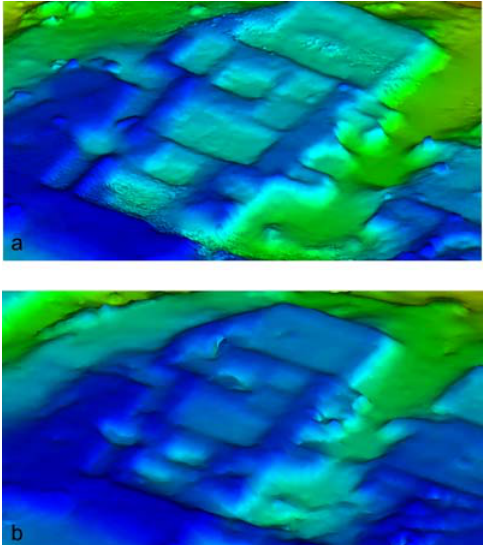
Figure 6. Views of surfaces obtained from DEMs: a) NCP case; b) CP